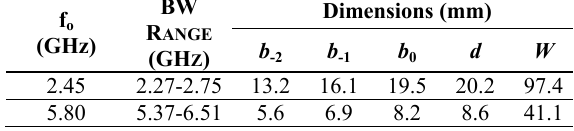
= 1. and d = 1.0384 b . 0 0